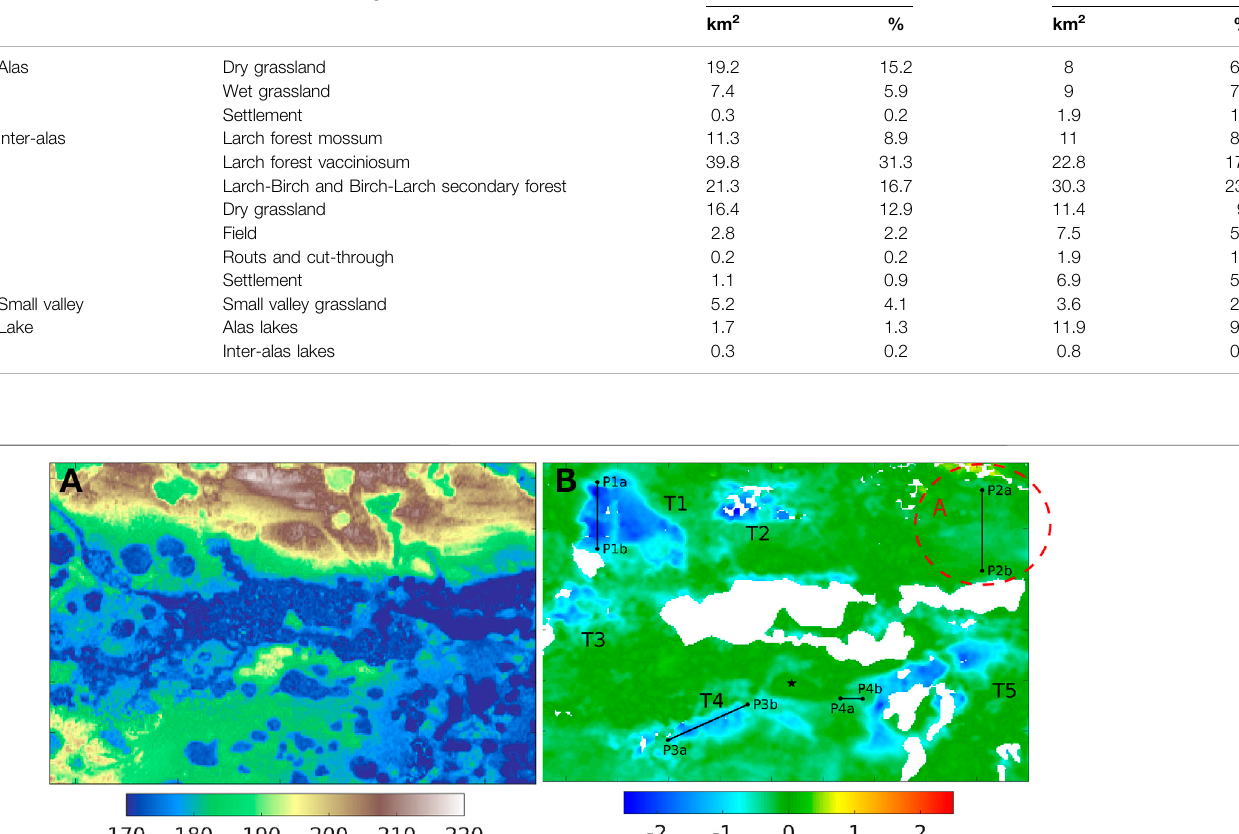
TABLE 2 | Landscape characteristics of Churapcha in 1945 and 2009 (after Gorokhov et al., 2011). The targeted area is shown in Figures 2C,D . Terrain